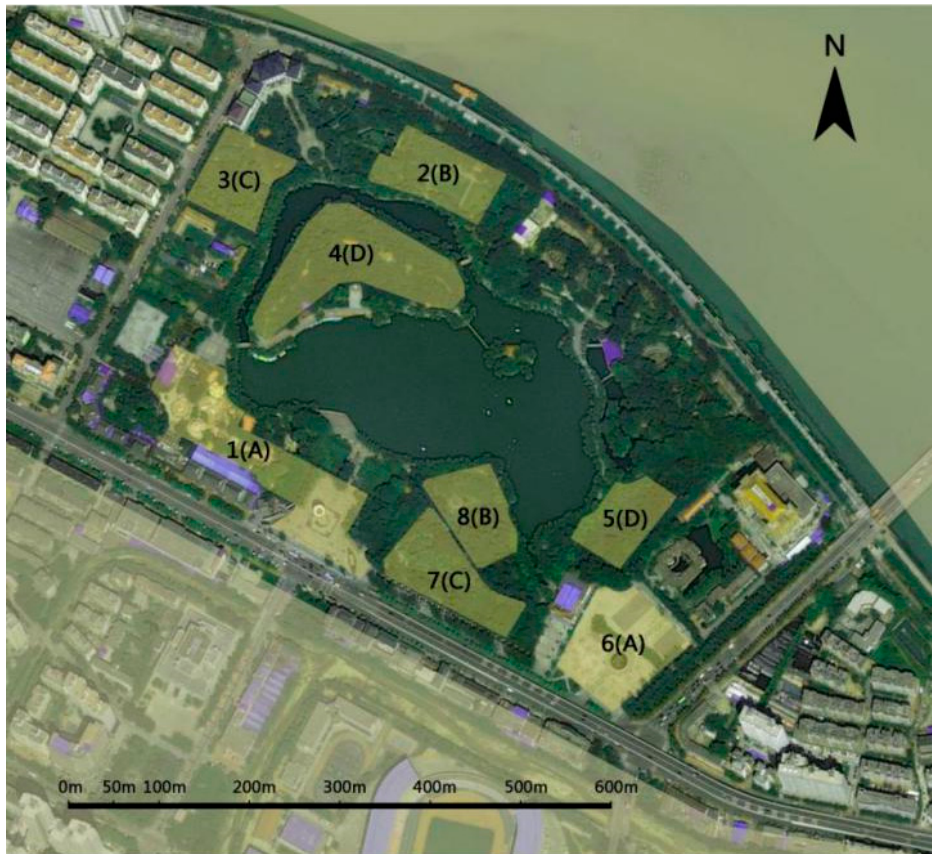
Figure 2. Site zoning of the People’s Park (PP) according to visual differences in landscape characteristics and vegetation structure. 1-8 represent eight visually different zones based on location, landscape attributes, composition structure and distribution characteristics of vegetation. A-D represent four different habitat types with similar characteristics but they are detached.